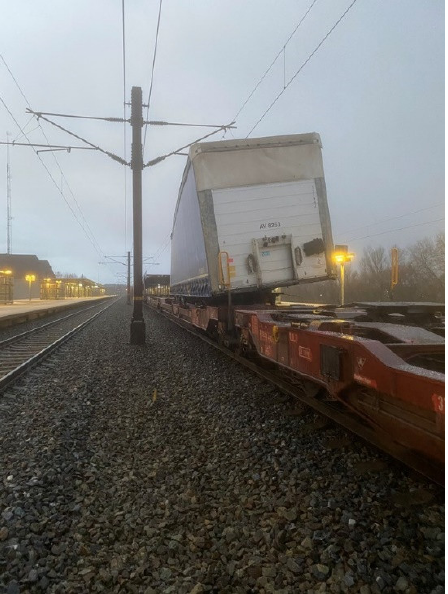
Figure 1. In 2021 during the passage of a freight train over the bridge, the semi-trailer was forced out of its attachment (strong wind and empty trailer), source: utk.gov.pl [8].